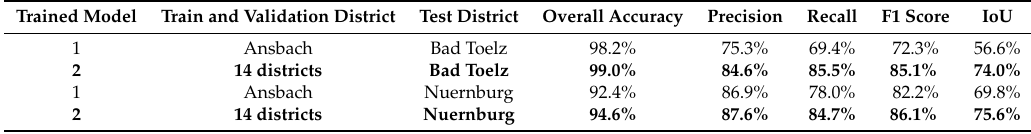
Table 5. Accuracy of two different trained models evaluated in the districts of Bad Toelz and Nuernburg.